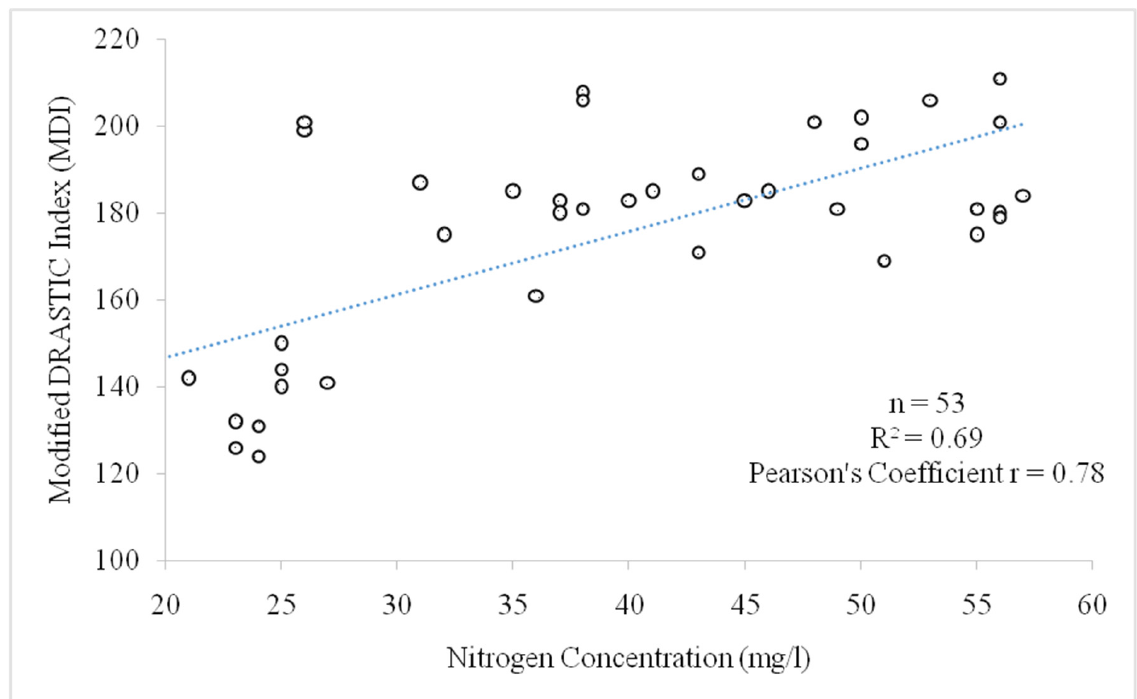
Figure 10. Plot between nitrate concentration (mg/L) and DRASTIC index (DI).